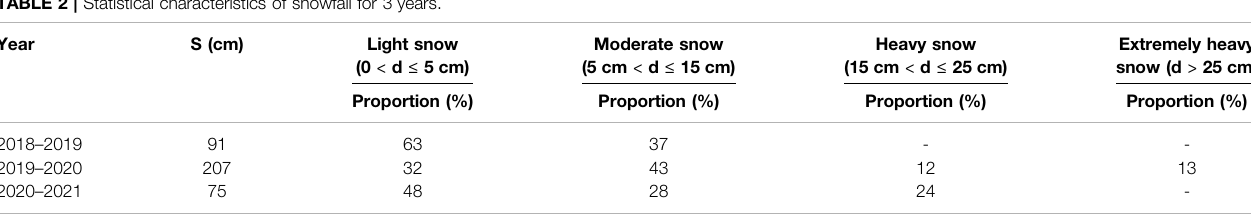
TABLE 2 | Statistical characteristics of snowfall for 3 years.